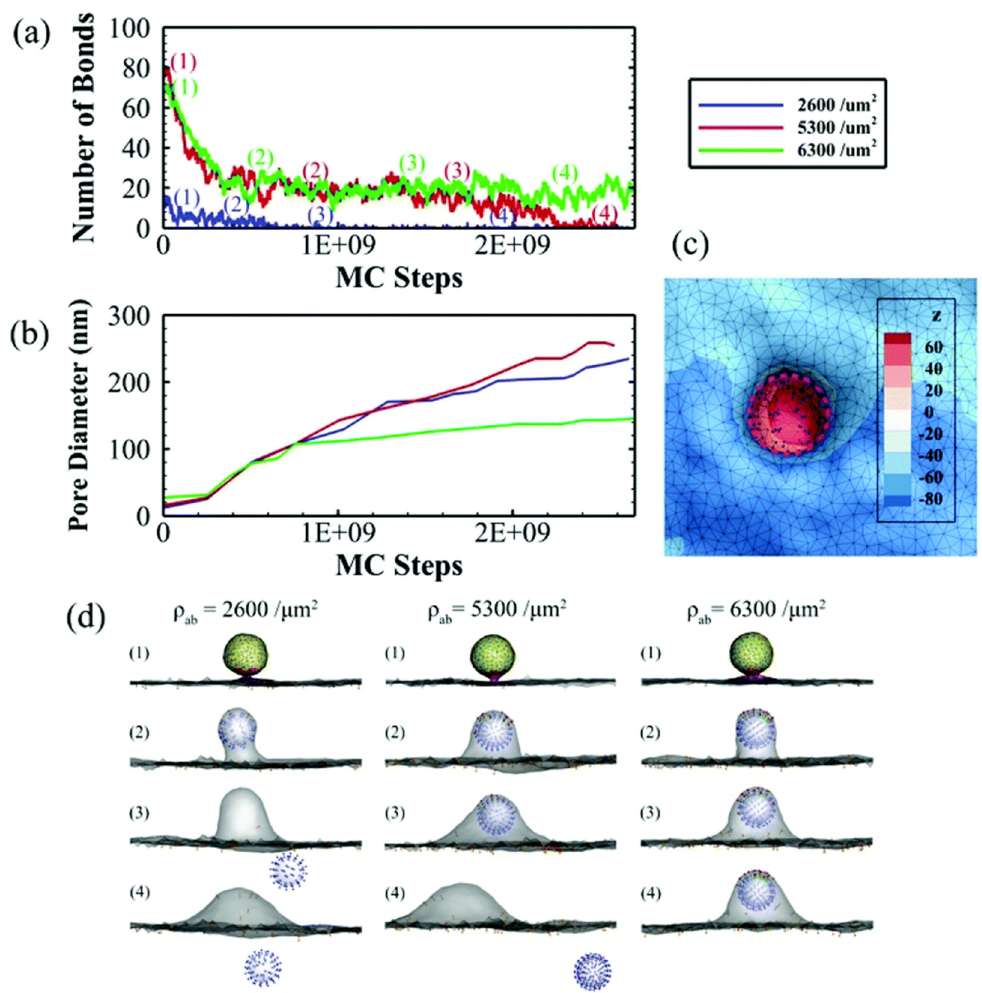
Figure 6. Simulations of the exocytosis of ligand-functionalized nanoparticles with three different densities of ligands ( ρ ab = 2600, 5300 and 6300 µm − 2 ) on the receptor-mediated transcytosis across polarized cells. ( a ) Number of bonds formed between ligand and receptor. ( b ) Fusion pore formation with diameter progression. ( c ) Bottom view of the membrane and pore diameter. ( d ) Evolution of the vesicle interaction with membrane and fusion pore formation followed by detachment from the membrane for sufficiently low ligand densities. Nanoparticles are considered rigid spheres and ligands are considered pH independent. The last condition guarantees that the number of bonds and receptors that is at the end of endocytosis is the same as the number that is at the beginning of exocytosis. Adapted with permission from Reference [65], Royal Society of Chemistry, 2019.